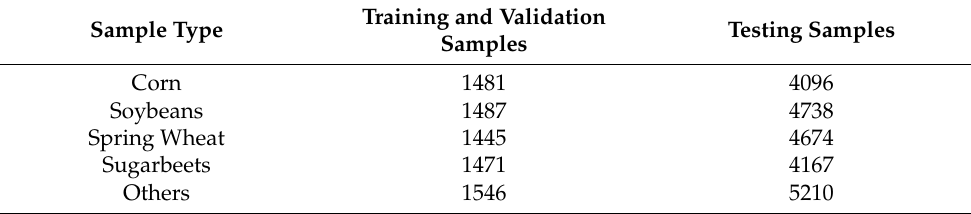
Table 3. The five categories used in the present study for classification and the number of